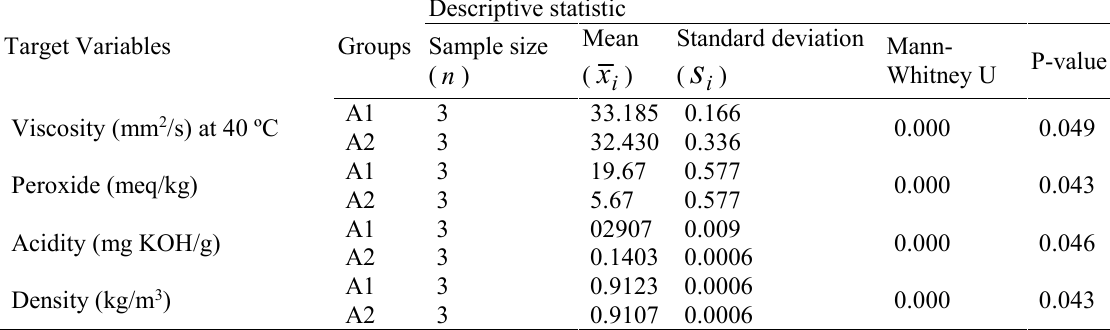
Table 1. Descriptive statistics of waste oil properties (A1: waste oil, A2: waste oil after adsorption